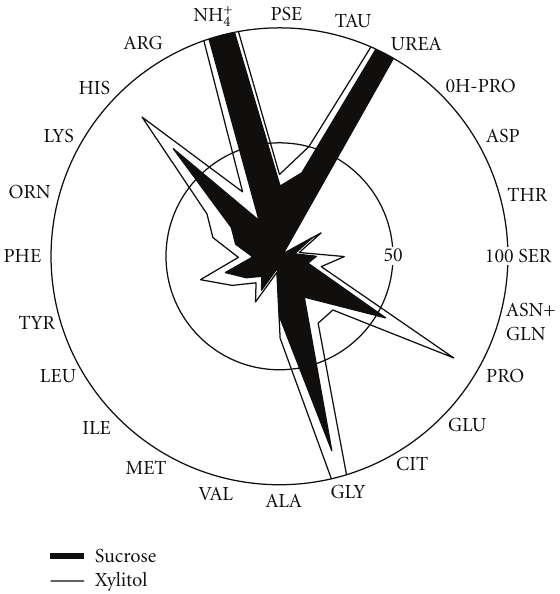
Figure 5: An important sialochemical e ff ect of xylitol diet. Increase of the free amino acid content (in μ mol/L, thin line) of whole- mouth saliva after long-term consumption of a xylitol diet, shown in a polar co-ordination diagram [13]. The analysis was carried out on pooled saliva of subjects who had consumed the xylitol diet for 12 to 16.5 months (average consumption level of xylitol: about 65g/day). The solid black area shows the free amino acid levels in saliva of subjects who consumed a regular sugar-containing diet. The high levels of ammonia and most amino acids (which can in turn serve as sources of further ammonia production) speak for reduced plaque acidity and increased nitrogen metabolism in dental plaque from which a large part of the free amino acid pool of whole-mouth saliva is derived. Non-standard abbreviations: CIT = citrulline; TAU = taurine; PSE = phosphoserine. Reproduced with permission